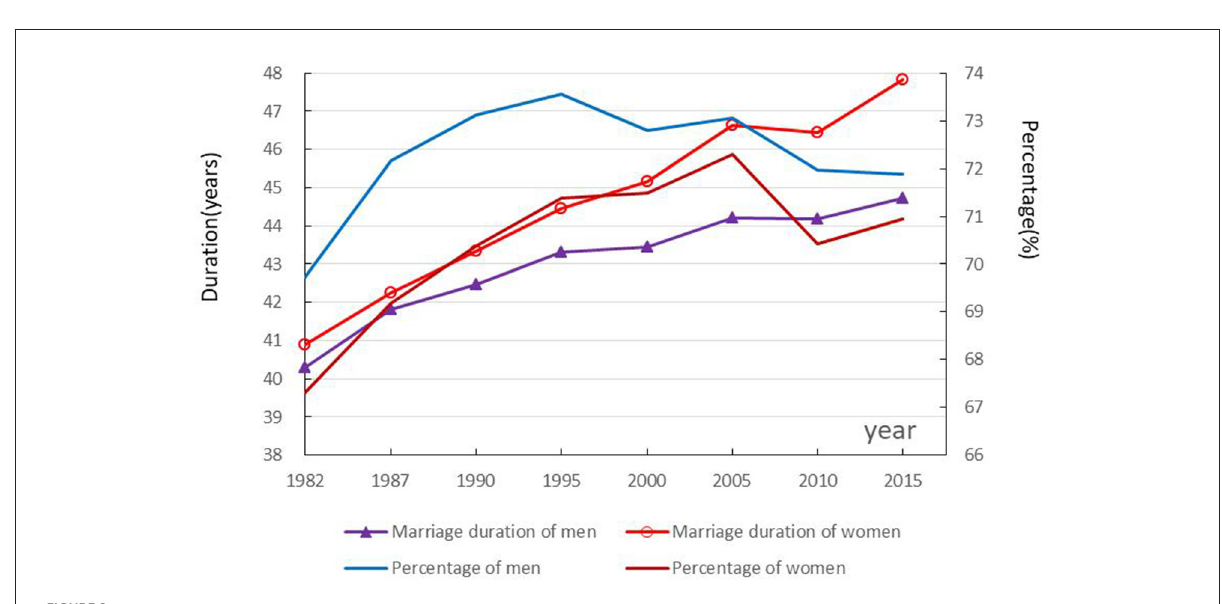
shows that the gender difference in the proportion of never- married people has a larger positive effect on gender difference in the single duration, decreasing from 4.16 years in 1982 to 3.08 years in 2015; the gender difference in mortality has a smaller negative effect on gender difference in the single duration, increasing from 0.05 years in 1982 to 0.09 years in 2015.